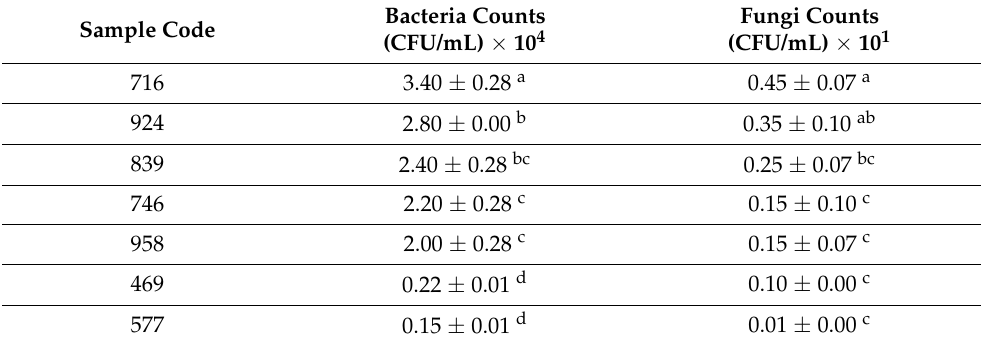
Table 2. Microbial counts of fermented millet “ Ibyer ” beverage enhanced with ginger